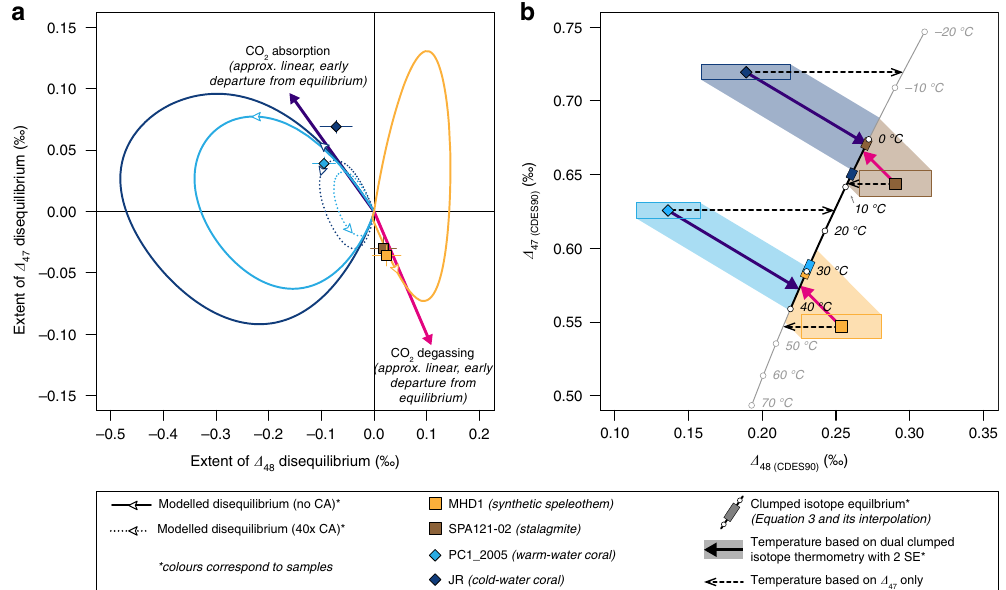
Fig. 3 Agreements between model predictions and measured data allow accurate reconstruction of carbonate formation temperatures despite kinetic bias. a The deviations from clumped isotope ( Δ 47 and Δ 48 ) equilibrium observed in the warm- and cold-water corals and the synthetic speleothem agree with the model-predicted kinetic departures 26,27 . Carbonic anhydrase accelerates oxygen isotope and clumped isotope exchange among different DIC species during CO 2 absorption. The white arrows on the model lines depict the temporal evolution of the predicted disequilibrium effects and are positioned to mark t = 500 s in the CO 2 absorption model simulations and t = 170 s (i.e., when 50% of carbonate precipitation proceeded) in the speleothem model simulation, respectively (Methods, Supplementary Data 5). Note, that unlike the speleothem model that simulates the exact formation of our synthetic speleothem sample, the CO 2 absorption model is a simpli fi cation of coral calci fi cation process and thus the timing information in the model has no direct implication on the timescale of coral calci fi cation process. The models predict an almost linear correlation between Δ 47 and Δ 48 disequilibrium during the early stage of CO 2 absorption and CO 2 degassing, with slopes of − 0.6 and − 1.0, respectively (the purple and the pink arrows; Supplementary Data 5). b Kinetic effects lead to signi fi cant underestimation of the coral growth temperature but overestimation of the speleothem formation temperatures based on their Δ 47 compositions alone (horizontal, dashed arrows). However, using the model-predicted kinetic slopes, i.e., − 0.6 for corals (purple arrows) and − 1.0 for speleothems (pink arrows), the isotopic composition of these samples can be projected onto the Δ 47 vs Δ 48 equilibrium curve to derive more accurate estimates of carbonate formation temperatures 26,27 . Temperatures estimated this way are devoid of kinetic bias and agree within 2 SE with the actual carbonate growth temperatures. All error bars and rectangles depict 2 standard errors (95% con fi dence interval 35